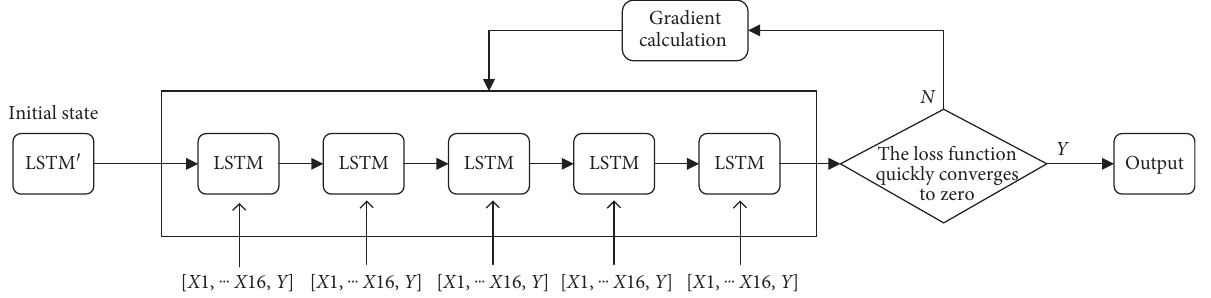
Figure 2: Training structure of the LSTM model.